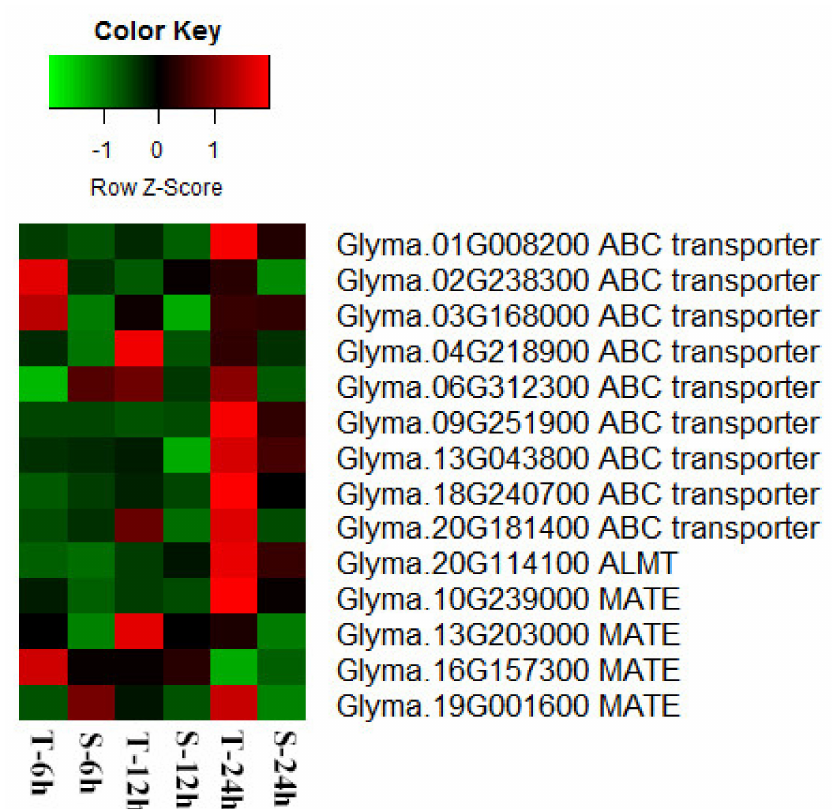
Figure 6. Transcriptional changes of Al tolerance-related transporter genes in response to Al stress in the roots of KF (T) and GF (S) soybean varieties. The heatmap was constructed using the R package gplots. The color key represents the fold change (Al vs. control) scaled by row. ABC transporter: ATP-binding cassette transporter. ALMT: Aluminum activated malate transporter. MATE: Multidrug and toxic compound